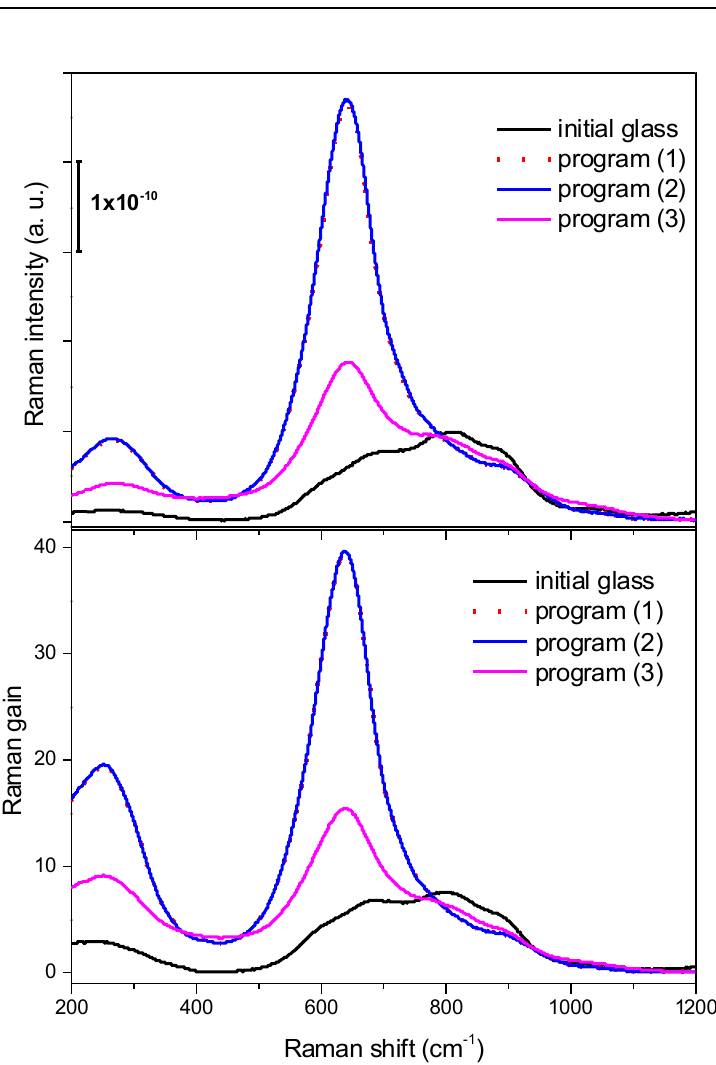
Figure 4. Reduced Raman spectra ( up ) and Raman gain ( down ) of the initial BaNaNS glass and nucleated samples subjected to different thermal treatments.